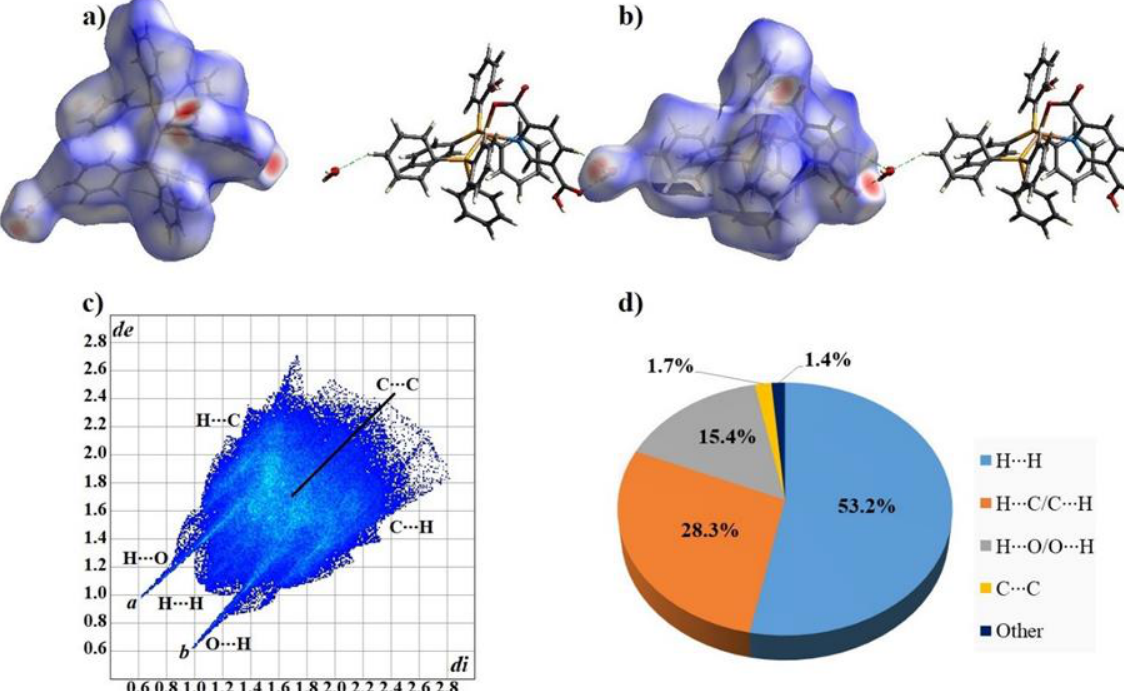
Figure 2. ( a , b ) Hirshfeld surface maps ( d norm ) of compound 1 viewed from different perspectives. ( c ) Fingerprint plot. ( d ) Contributions of different types of intermolecular interactions.